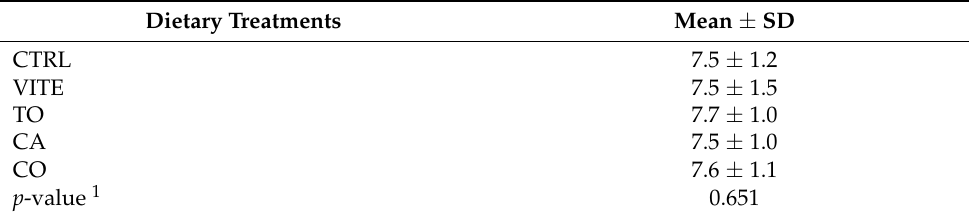
Table 8. Overall liking of fish samples with different dietary treatments.